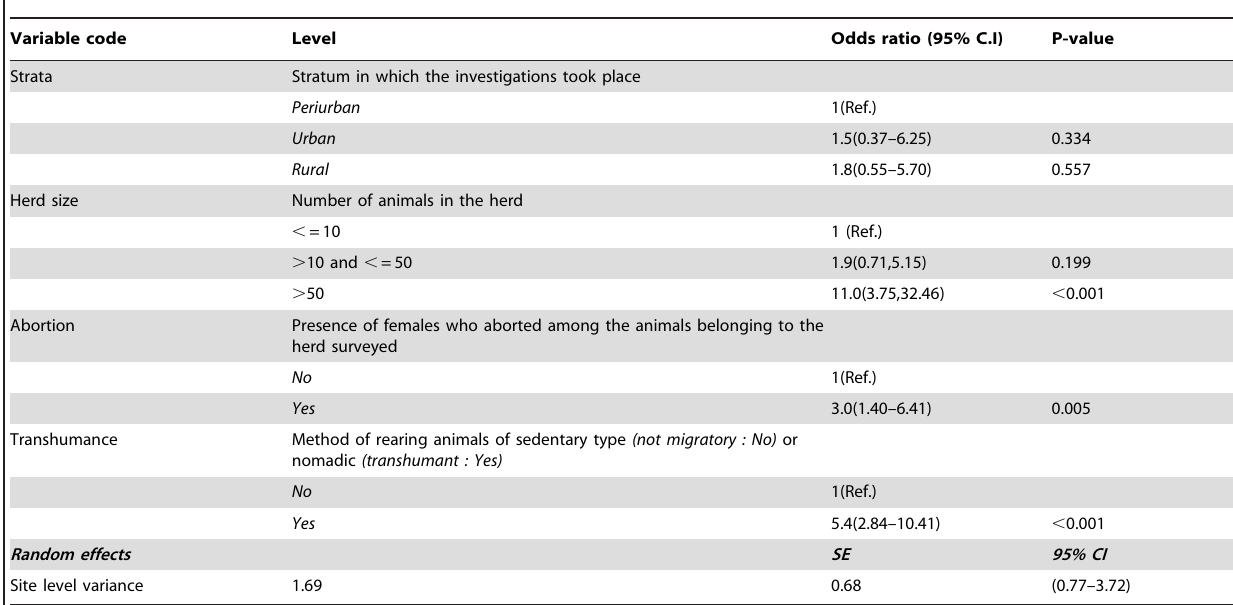
Table 7. Final model of herd-level risk factors associated with brucellosis sero-positivity among 681 herds which nested within 45 sites.